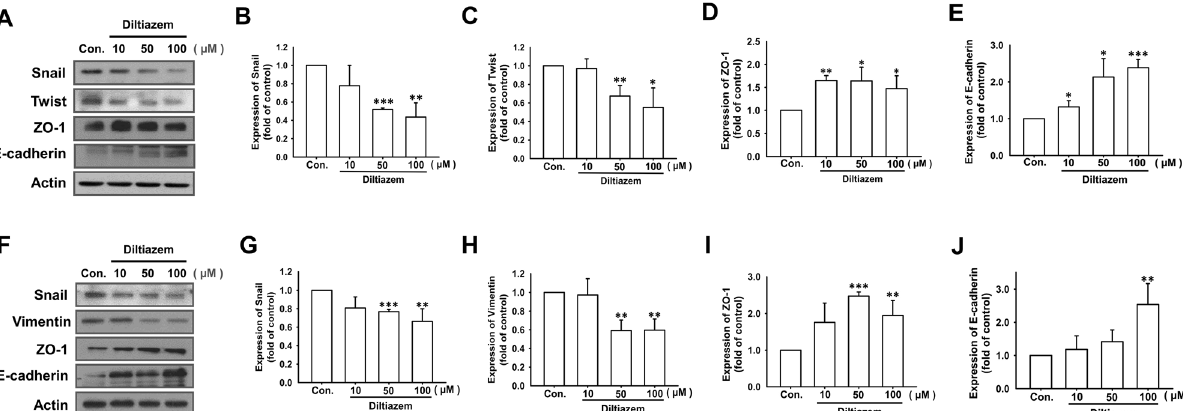
Fig. 2 Diltiazem abrogates epithelial-mesenchymal transition by increasing epithelial markers expression and decreasing mesenchymal markers expression in breast cancer cell lines. Cells were treated with diltiazem (10 – 100 μ M) for 24 h, and protein expressions were detected by Western blot. It is shown that diltiazem decreased the expression of mesenchymal markers (Snail, Twist and vimentin) but increased the expression of epithelial markers (E-cadherin and ZO-1) on 4T1 ( A – E ) and MDA-MB-231 ( F – J ) breast cancer cells. Graphs showed mean ± S.D. of three independent experiments. p value was calculated using Student ’ s t test. * p < 0.05; ** p < 0.01; *** p < 0.001 compared to control group.